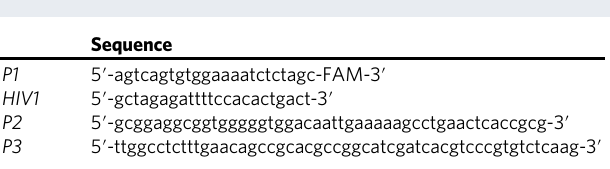
Fig. 9 In vivo therapeutic performance in the HeLa tumor xenografts. a The relative tumor volumes. b The volumes and weights of tumor dissected from each group after therapy. c The body weights of mice. d The survival curves of HeLa tumor-bearing mice. e Example photos of tumor xenograft mice and histopathology images of dissected HeLa tumor xenografts stained for H&E or TUNEL assay. Scale bar: 50 μ m. Table 1 The sequences of the